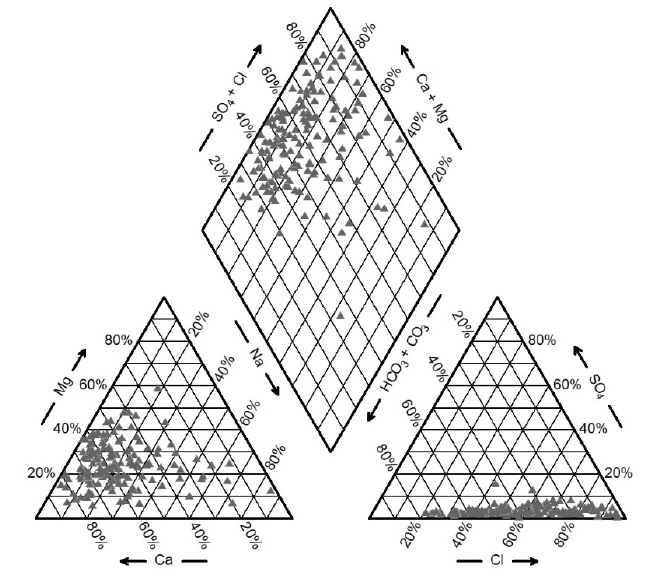
Figure 12. Piper diagram of groundwater samples. Table 3. Statistic values of major groundwater ions, TDS, and pH (number of sampling points: 153).